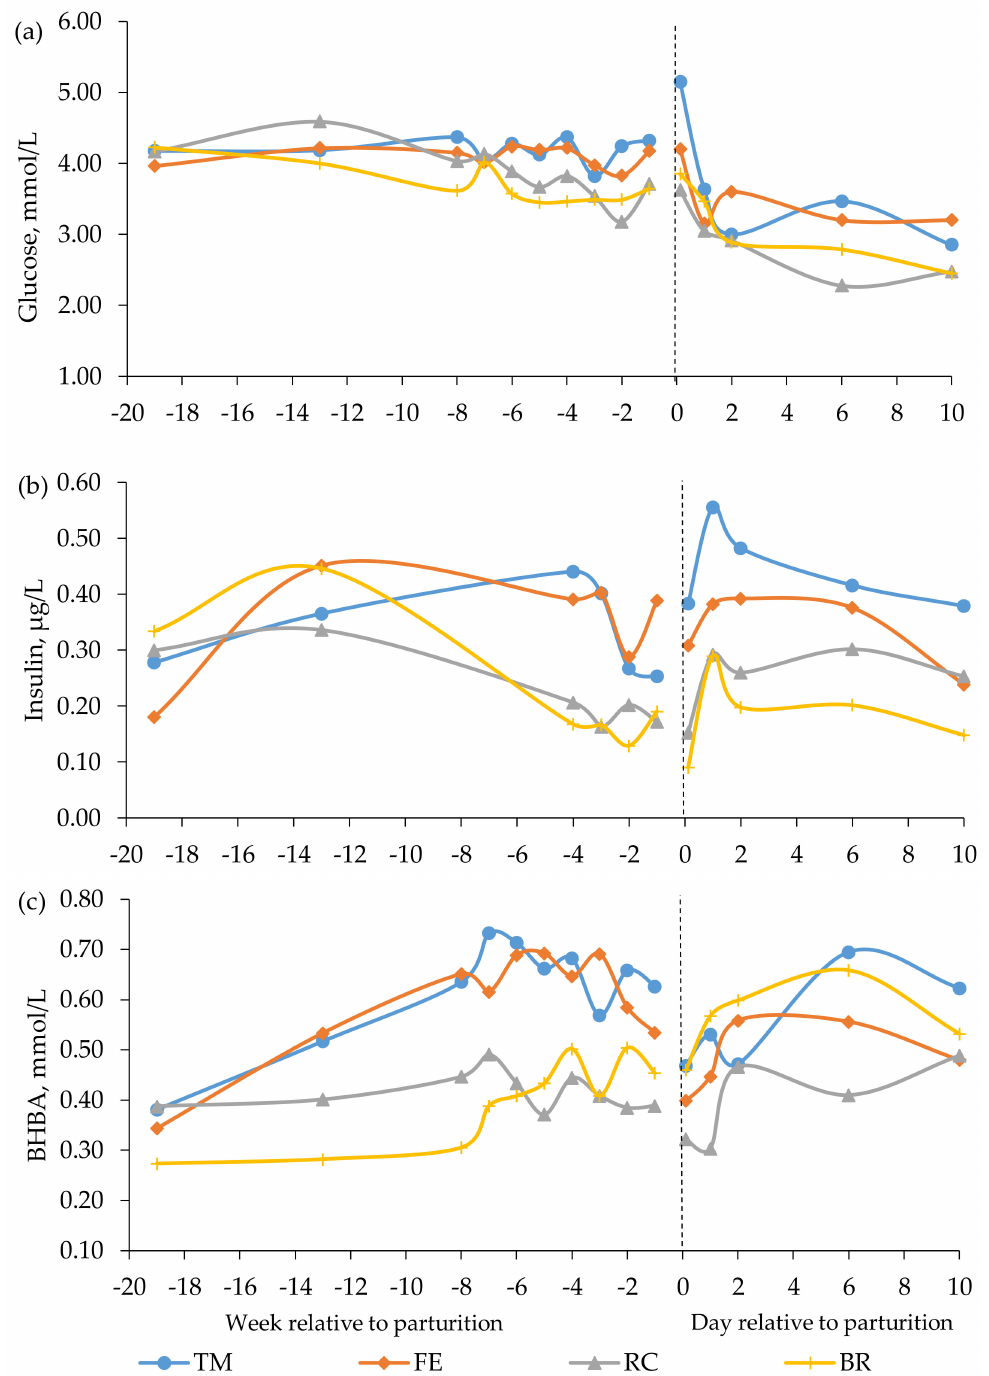
Figure 2. Blood concentrations of ( a ) glucose, ( b ) insulin, and ( c ) beta-hydroxybutyrate (BHBA) in beef cows fed timothy-meadow fescue silage (TM), festulolium silage plus urea mix (FE), reed canarygrass silage (RC), and barley straw plus urea mix (BR) ad libitum prepartum, including additional supplementation of rapeseed meal for cows on the BR diet. All cows received the same timothy grass silage ad libitum postpartum. Prepartum week -19 indicates the zero value (sampled prior to initiation of the prepartum dietary treatments). The dashed line indicates time of calving (week 0). Blood was sampled within 3 h ( ± 4.1) of parturition, at 24 h ( ± 4.7) and 48 h ( ± 2.9), and on day 6 and 10 postpartum. Prepartum and postpartum n = 7–9 cows / diet in each data point. The diet × time interaction approached significance ( p = 0.052) for prepartum plasma levels of